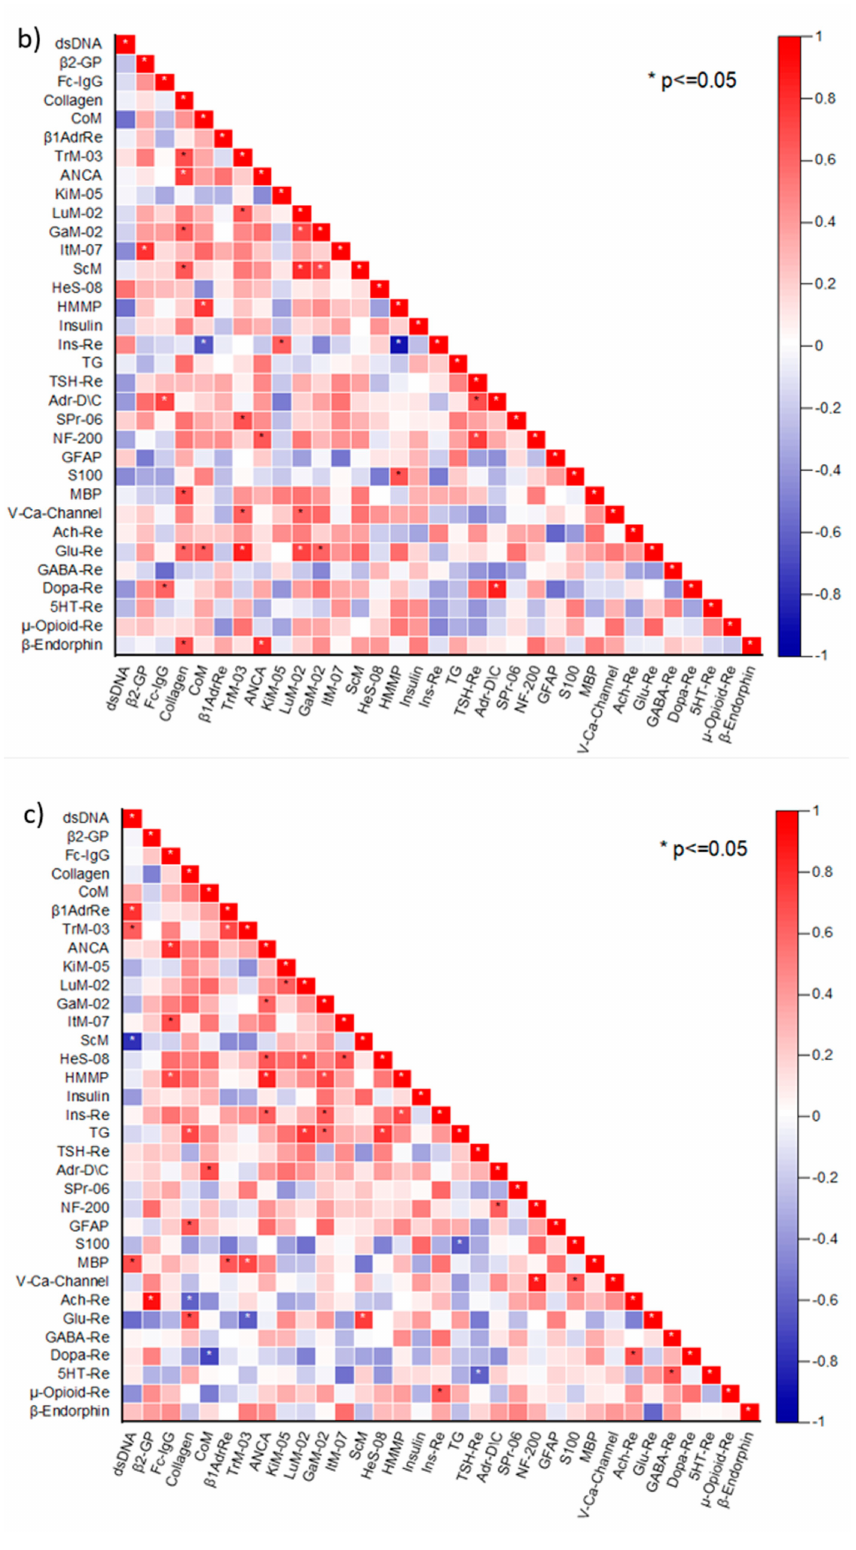
Figure 1. Correlation matrices of AAb targeting organ-specific, neural, and non-organ-specific antigens (denoted by abbreviations as per legend in Table 1) for ( a ) ME/CFS( − )FM ( n = 11), ( b ) ME/CFS(+)FM ( n = 11), ( c ) healthy controls ( n = 11). The color scale bar represents the range of Spearman’s rank correlation coefficient. Significant correlations are marked with